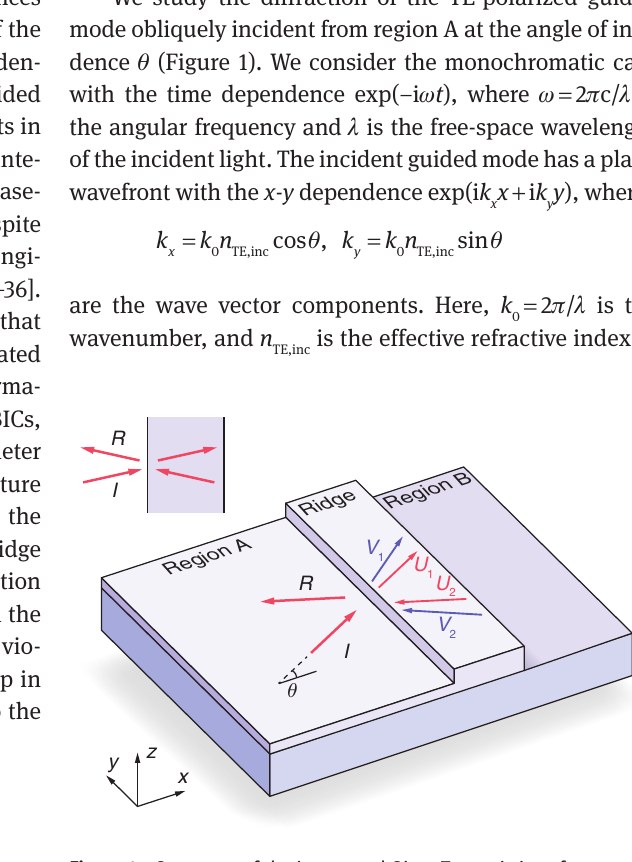
Figure 1: Geometry of the integrated Gires-Tournois interferometer (the structure is translation-invariant in the y -direction). The arrows depict the propagation directions of the slab waveguide modes inside the structure. Red arrows show TE-polarized modes and blue arrows show TM-polarized modes. The inset shows the conventional